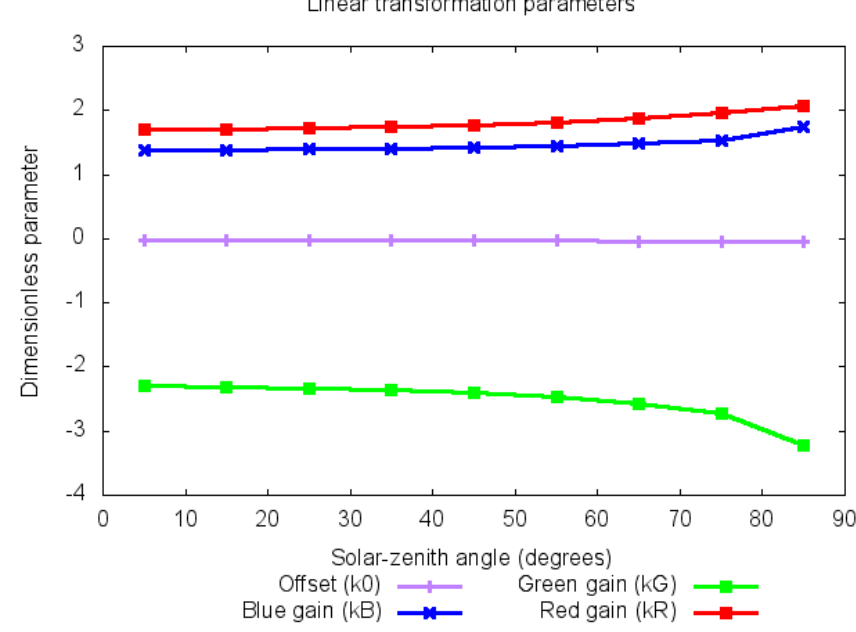
Figure 8. Spectral fit parameters as function of the solar-zenith angle. The solar-zenith angle θ sz ranges from 5° to 85°, in steps of 10°. The offset k o ( θ sz ) is nearly zero and the sum of the gains k R ( θ sz ) + k G ( θ sz ) + k B ( θ sz ) is close to 1. The blue gain k B ( θ sz ) increases with θ sz due to increased Rayleigh scattering at high θ sz and, consequently, induces a variation of the red gain k R ( θ sz ) and the green gain k G ( θ sz ) .